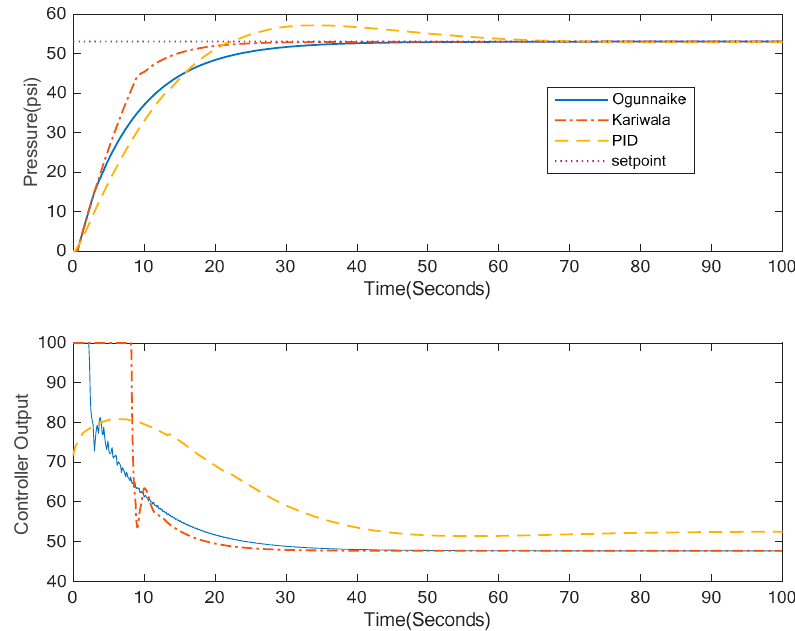
Figure 23. Comparison of the servo response for the pressure control station with two tuning rules and PID.